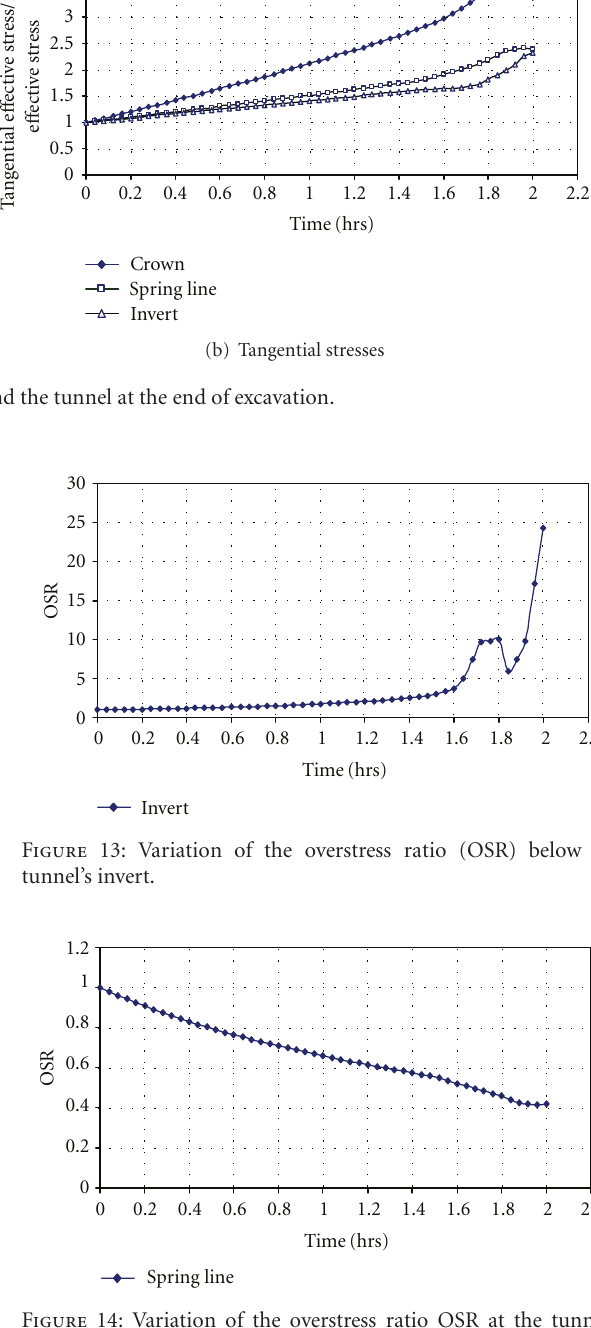
Figure 14: Variation of the overstress ratio OSR at the tunnel’s spring